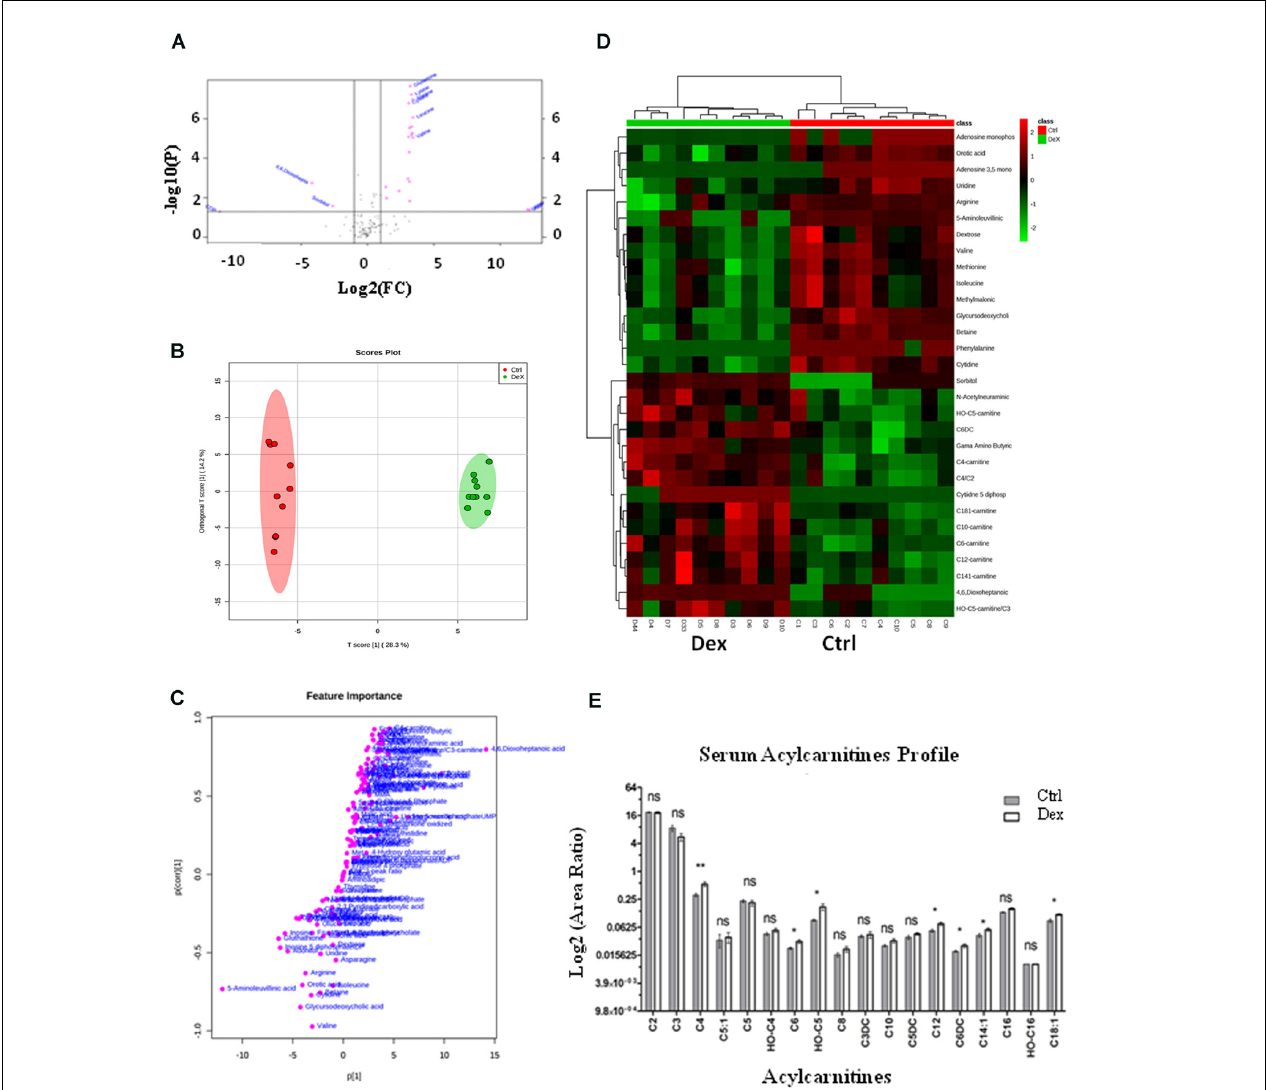
FIGURE 3 | Dexamethasone effects on serum targeted metabolites. (A) Important features selected by volcano plot analysis with fold change threshold ( x -axis) at 1.2 and t -tests threshold ( y -axis) at 0.05. Pink circles represent features above the threshold. Please note both p -values and fold changes are log 10 and log 2 transformed, respectively. The further the feature’s position is away from the origin point (0,0), the more significant it is. (B) Separation of Ctrl and Dex groups using OPLS-DA score plot analysis ( Q 2 = 0.959). The t[1] and [1] values represent the score of each sample in principal components 1 and 2, respectively. (C) Loading S-plot generated by OPLS-DA analysis. The x -axis represents a measure of the relative abundance of ions, while the y-axis shows the correlation of each ion to the model. (D) Heatmap analysis showing the top significantly enriched features from t -test in Ctrl (red) and Dex treated (green) groups. (E) Serum levels of several acylcarnitines (C18:1, C14:1, C6DC, C12, OH-C5, C6, C4) were significantly increased ( p < 0.005) in the Dex treated